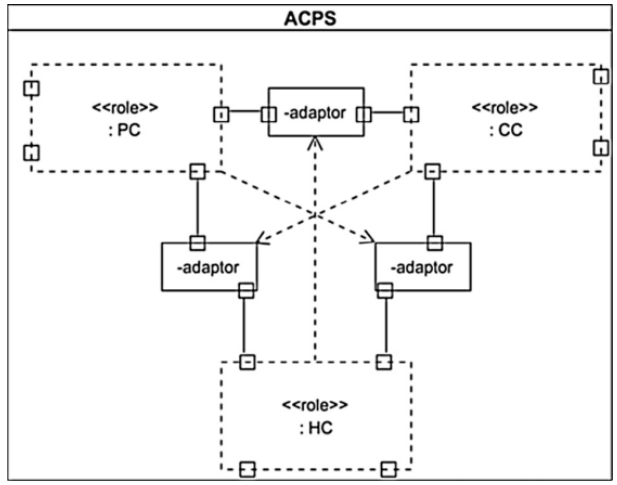
Figure 4. ACPS reference architecture (see [27]).